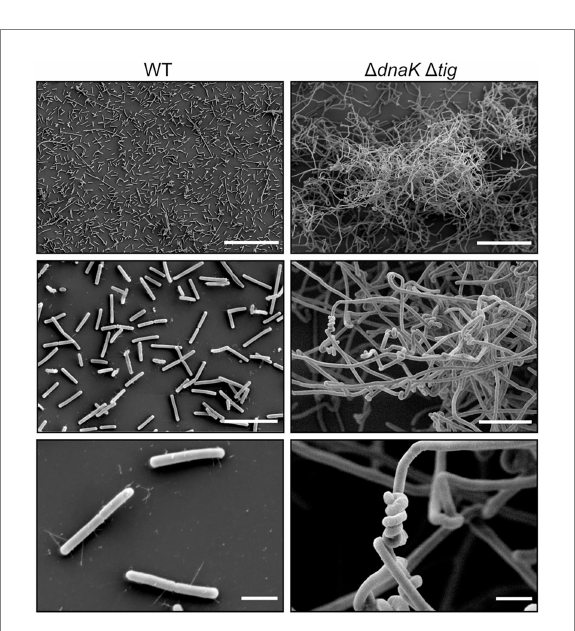
FIGURE 3 Twisted morphology of the dnaK tig double mutant. Representative SEM images of B. subtilis wild-type (1A1), on the left panels, and Δ dnaK Δ tig (LUW878), on the right panels. Scale bars represent 50 μ m for the top panels, 10 μ m for the middle panels, and 2 μ m for the bottom